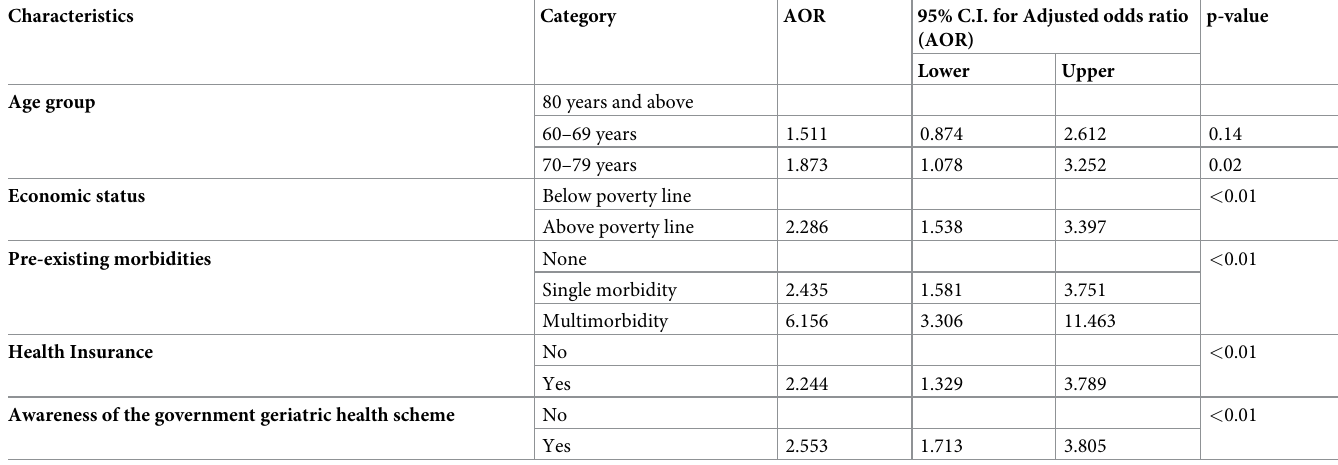
Table 6. Multivariable logistic regression analysis of different variables with health service utilization in the last months.